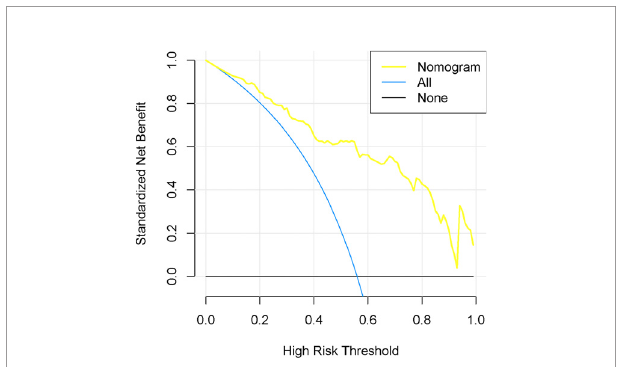
FIGURE 6 | Decision curve analysis for the nomogram in the training cohort. The y-axis represented the net bene fi t. The blue line represents the assumption that all have LNM. The black line assumes no LNM. The decision curves indicated that the nomogram was clinically